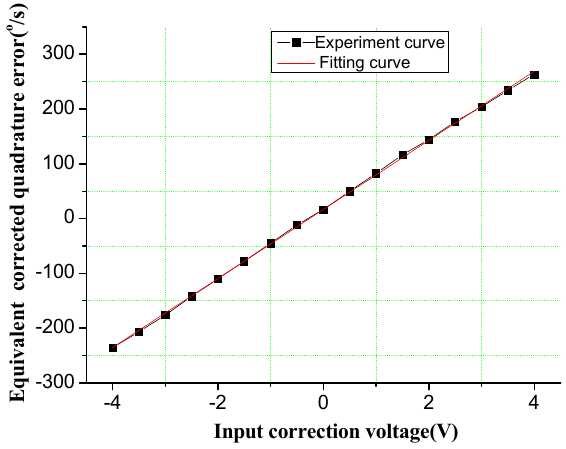
Figure 14. Correction capability experiment of quadrature error correction comb.